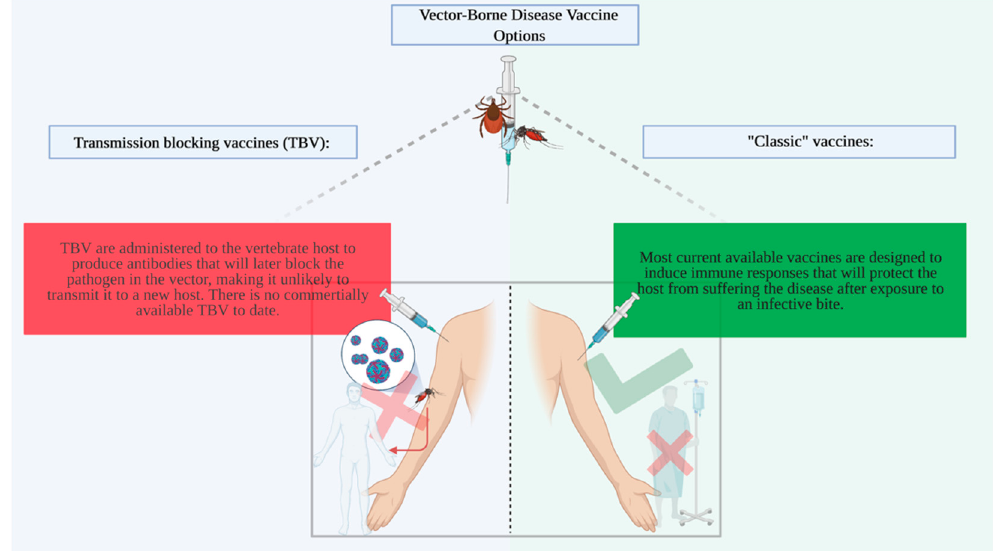
Figure 1 . Vaccine options to prevent vector-borne disease transmission. Transmission blocking vaccines (TBVs) are administered to the vertebrate host to induce immune responses that will later block pathogen development in the arthropod vector during or after the blood feeding. “Classic” vaccines are designed to prevent vertebrate infection and disease after exposure to an “infective” bite (figure created with BioRender.com) (accessed on 4 March 2021). Table 1. List of current licensed vaccines against